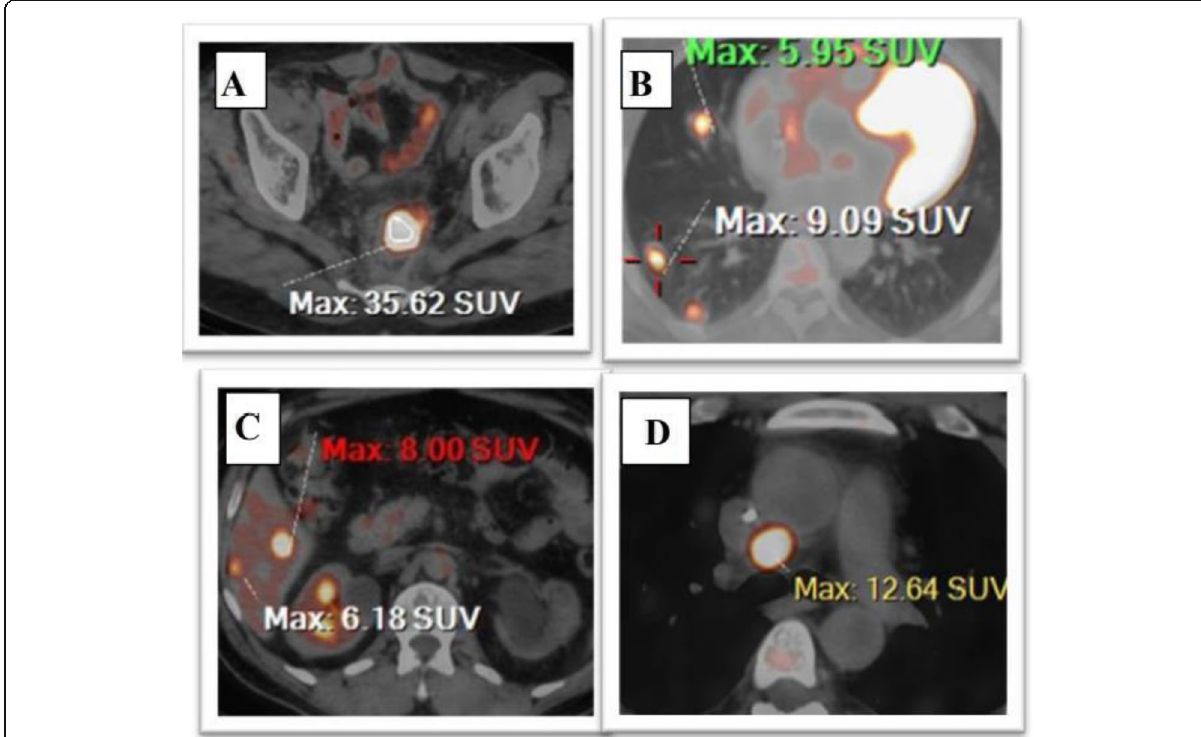
Fig. 4 A 55-year-old male with a surgically resected rectal cancer, presented by elevated CEA and was referred for PET/CT assessment. a , b , c , d Axial PET/CT images through the pelvis, chest, and abdomen showing the following: left pararectal hypermetabolic soft tissue lesion achieving 35.62 SUV max ( a ); multiple hypermetabolic metastatic pulmonary deposits, the most active of them achieved 9.09 SUV max ( b ) associated with hypermetabolic mediastinal lymph nodes, the most active of them achieve 12.64 SUV max ( d ); multiple hypermetabolic metastatic hepatic focal lesions, the most active of them achieve 8 SUV max ( c